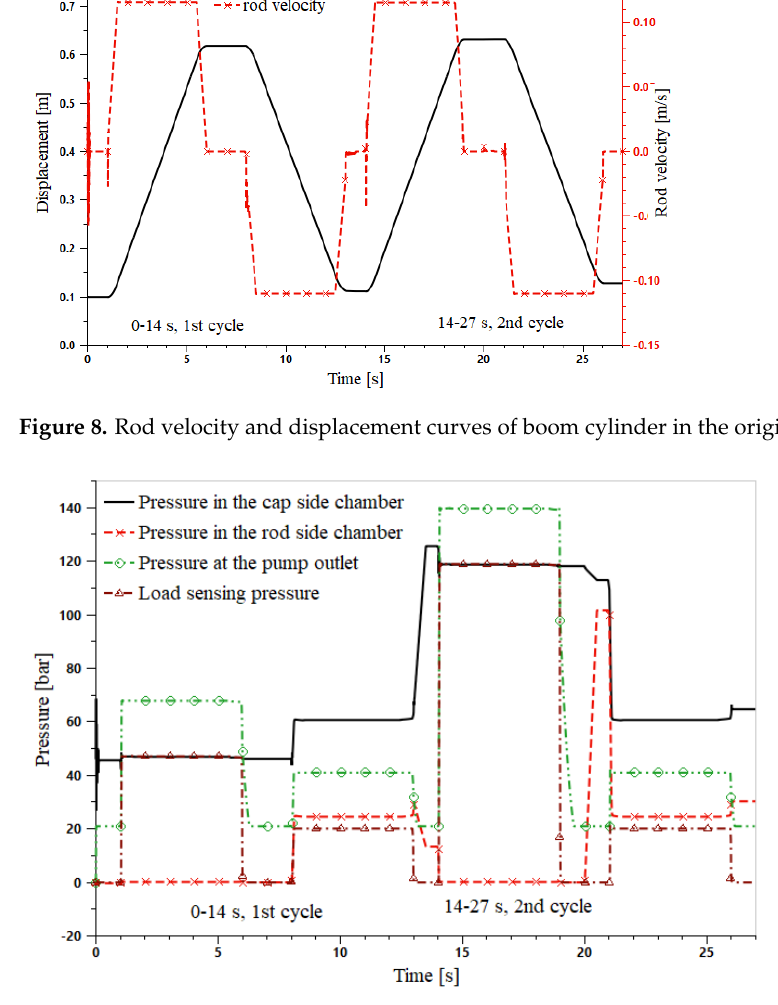
Figure 8. Rod velocity and displacement curves of boom cylinder in the original system.